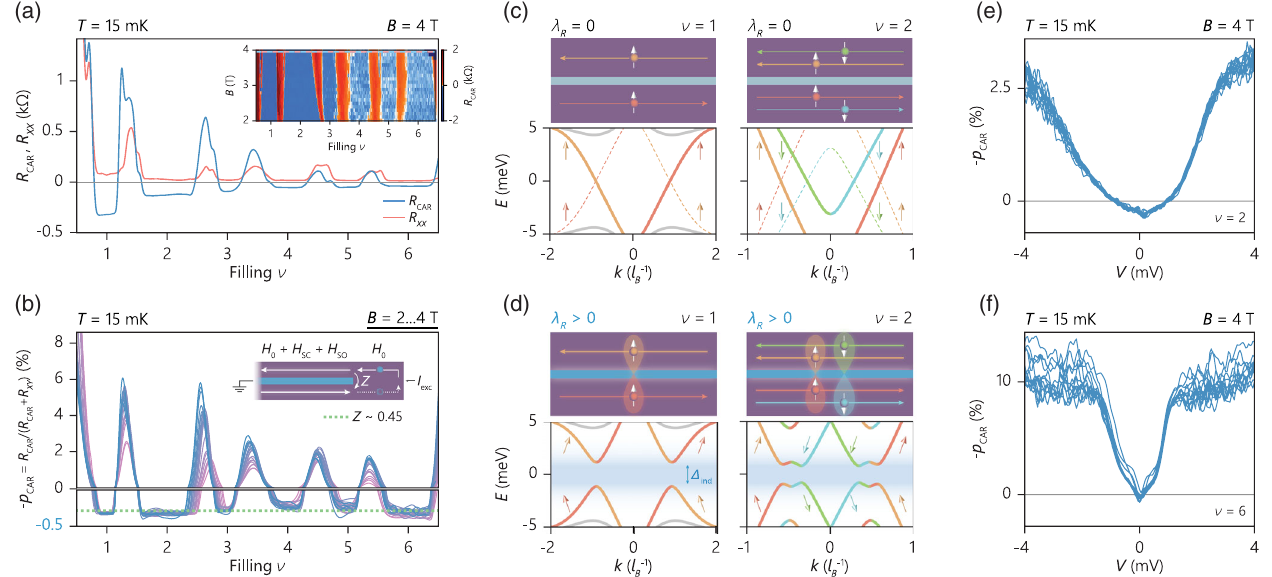
< 0 ). FIG. 2. Spin-orbit coupling. (a) R and R as a function of filling ν . All integer ν show crossed Andreev reflection ( R XX CAR CAR Small R indicates negligible bulk conductance. Inset of (a) shows R measured at B ¼ 2 ; … ; 4 T. (b) CAR probability p of the XX CAR CAR inset of (a). All integer ν , including the spin-polarized ν ¼ 1 , have a comparable p , an evidence for the pairing mechanism being the CAR same for all integer ν , enabled by spin-orbit coupling. The dashed line is the average p . H 0 is the Hamiltonian of the edges, H the SC CAR pairing, and H the spin-orbit Hamiltonian. Z represents incoming charges tunneling to the outgoing edge mode without Andreev SO ¼ 0 ) for ν ¼ 1 , reflection (direct tunneling). (c) Illustration of the edges separated by a superconductor without spin-orbit coupling ( λ R ¼ 0 ). Momentum k in units of l − 1 with l the 2, and their calculated Bogoliubov – de Gennes spectrum. No pairing gap is present ( Δ B ind B magnetic length. Solid lines are the electronlike excitations, dashed lines the holelike. Color code indicates the spin and the direction of . The only possible pairing is p wave for propagation. (d) Inclusion of spin-orbit coupling tilts the spins and enables a pairing gap Δ ind any integer ν irrespective of whether it is spin polarized or not. The inner edge modes pair more strongly due to their proximity to the superconductor. However, for low energy and temperature, p is expected to be independent of the size of Δ . Here, the value of λ R CAR ind is chosen to provide a spectral superconducting gap matching the experimentally relevant Δ (see Supplemental Material, Table S3 ind [35]). (e) p at ν ¼ 2 as a function of the incoming edge mode potential V (excitation) for different gate voltages spanning the entire CAR QH plateau region. Crossed Andreev reflection is limited to below j eV j ∼ 1 meV. (f) Same as (e) but at ν ¼ 6 . CAR is observed for j eV j < 0 . 2